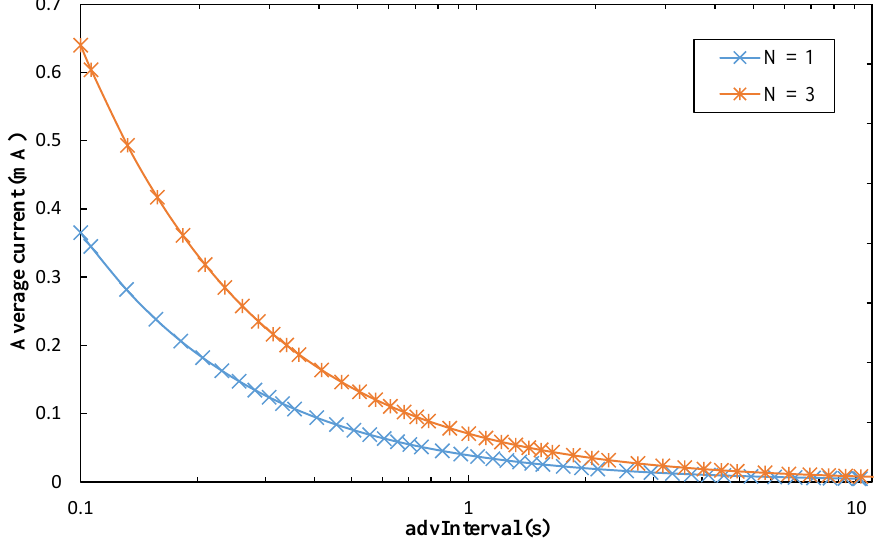
Figure 10. Average current consumption of the sensor node within connInterval ( I avg_CI ) in the connection-based approach, as a function of connInterval , and for BER = 0.